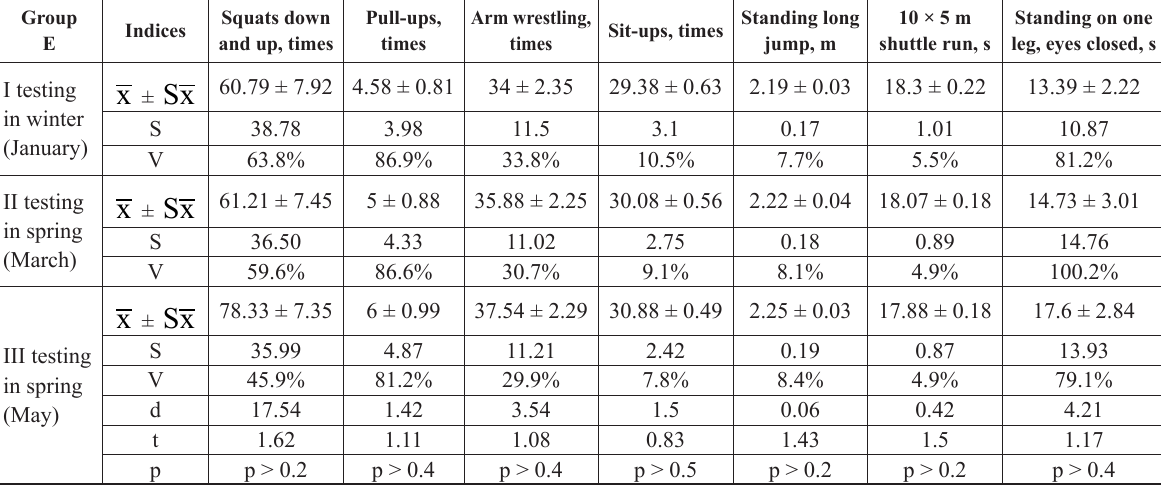
Table 1. Indices of E group schoolboys’ physical abilities